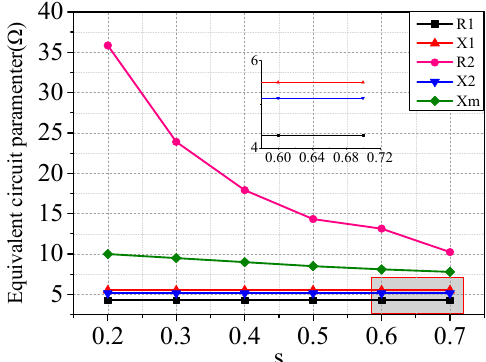
Figure 9. Computed results of equivalent circuit parameters.